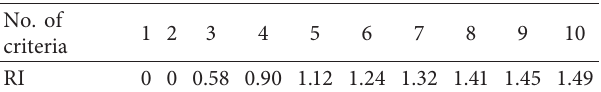
Table 1: Random index